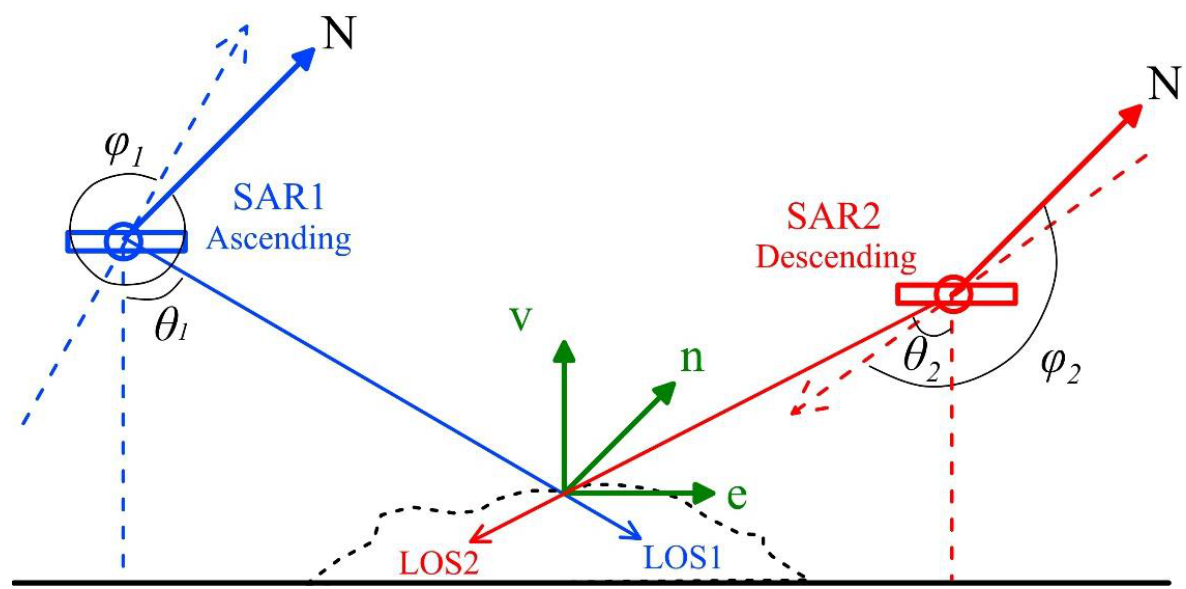
Figure 1. The satellite SAR imaging geometry along the ascending and descending orbits and the projection relation between the LOS displacement and the 3D motion components. The dashed arrows denote the flight directions of the ascending and descending